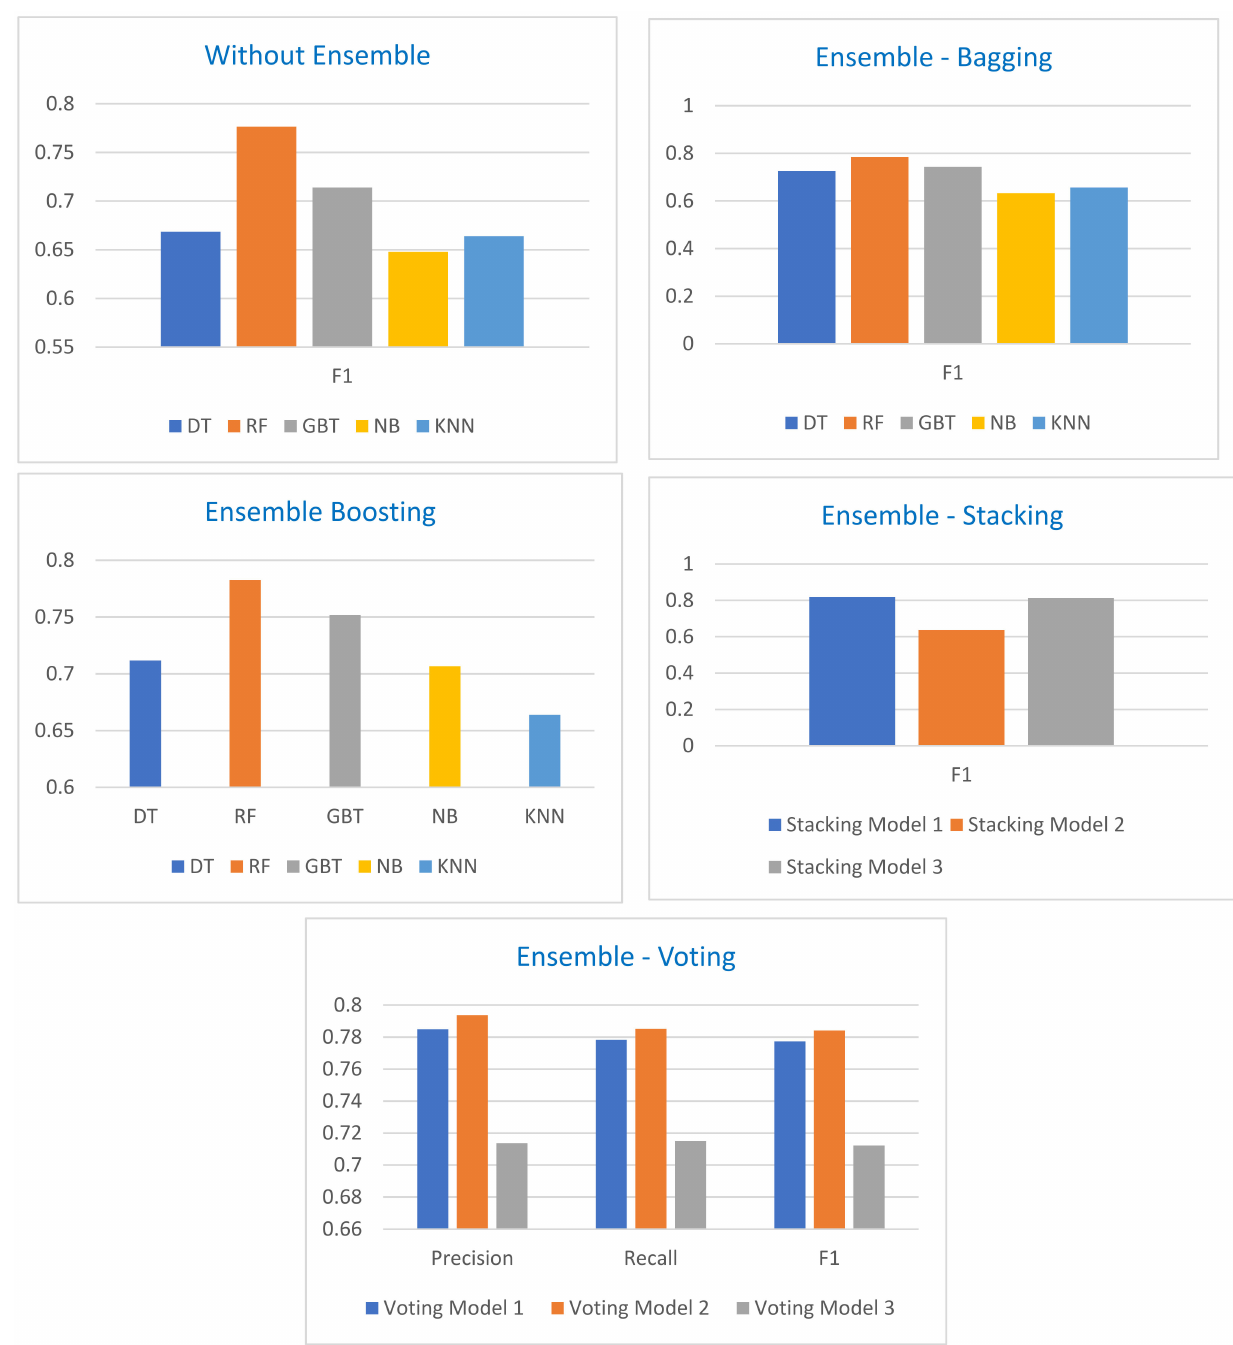
Figure 7. Comparison of weighted model’s performance achieved using different